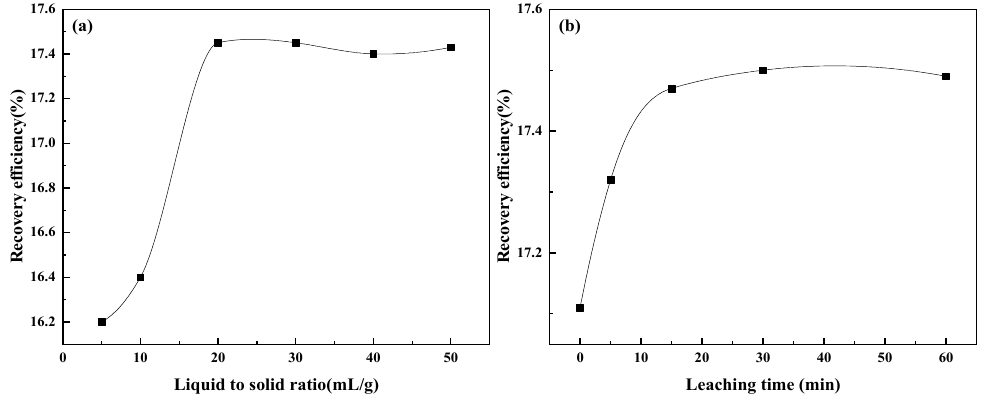
Figure 10. ( a ) E ff ect of liquid-to-solid ratio on recovery e ffi ciency of the crystallized product (washing Figure 10. ( a ) Effect of liquid-to-solid ratio on recovery efficiency of the crystallized product (washing time 30 min, temperature 60 ◦ C), ( b ) E ff ect of leaching time on recovery e ffi ciency of the crystallized time 30 min, temperature 60 °C), ( b ) Effect of leaching time on recovery efficiency of the crystallized product (liquid-to-solid ratio 20, and temperature 60 ◦ product (liquid-to-solid ratio 20, and temperature 60 °C).